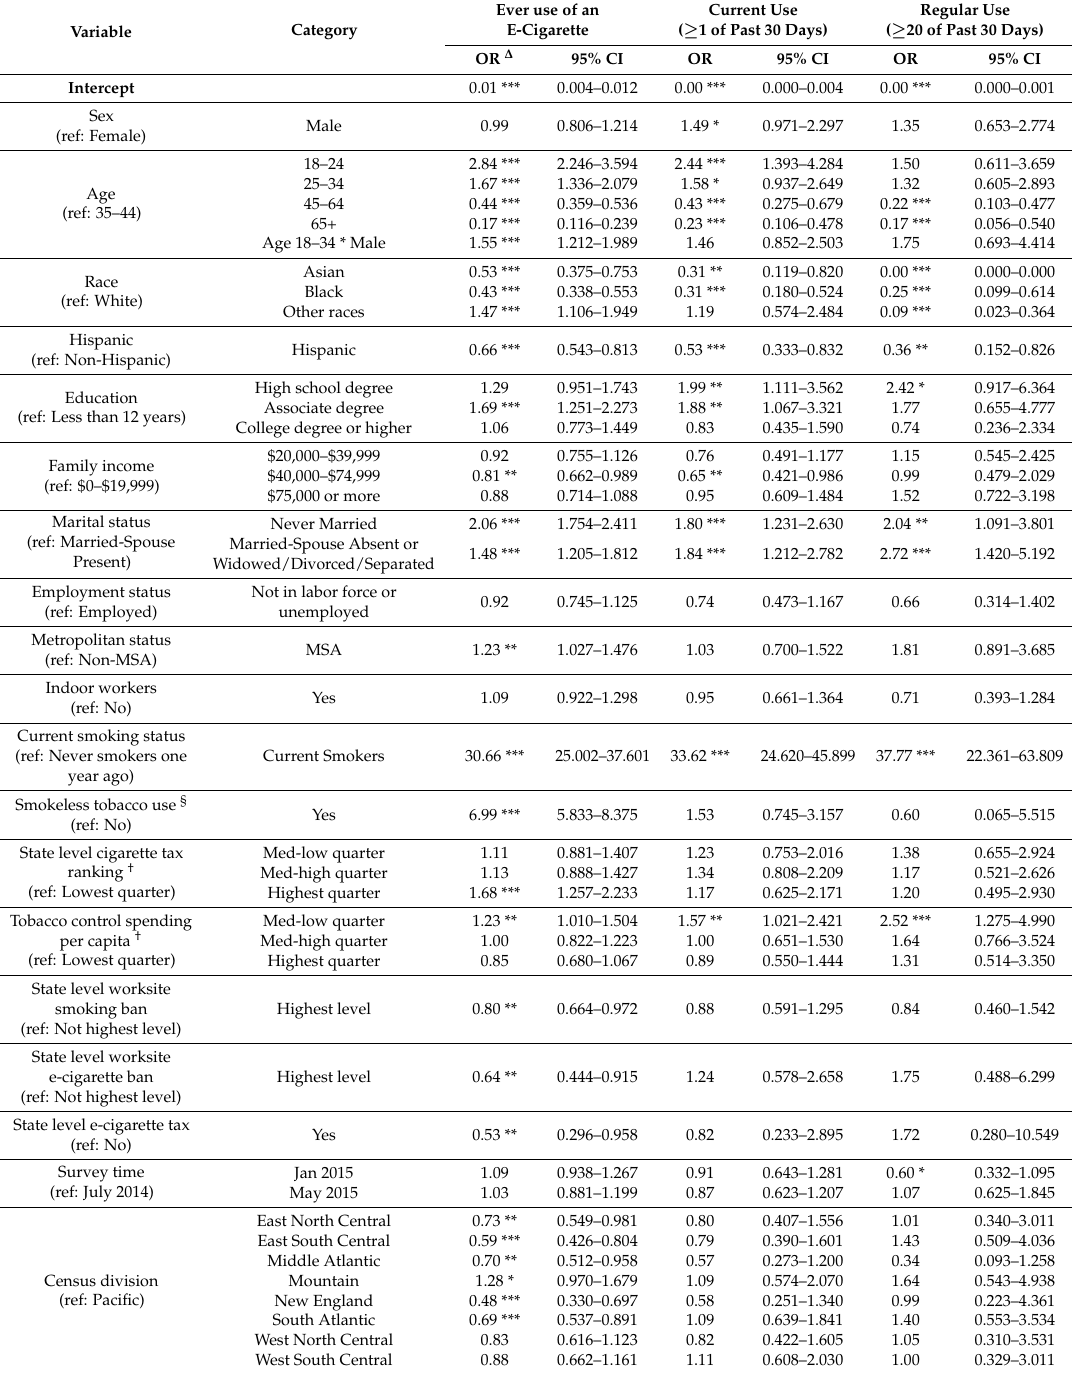
Table 6. Odds ratios for ever, current and regular measures of e-cigarette use for never smokers, CPS-TUS,